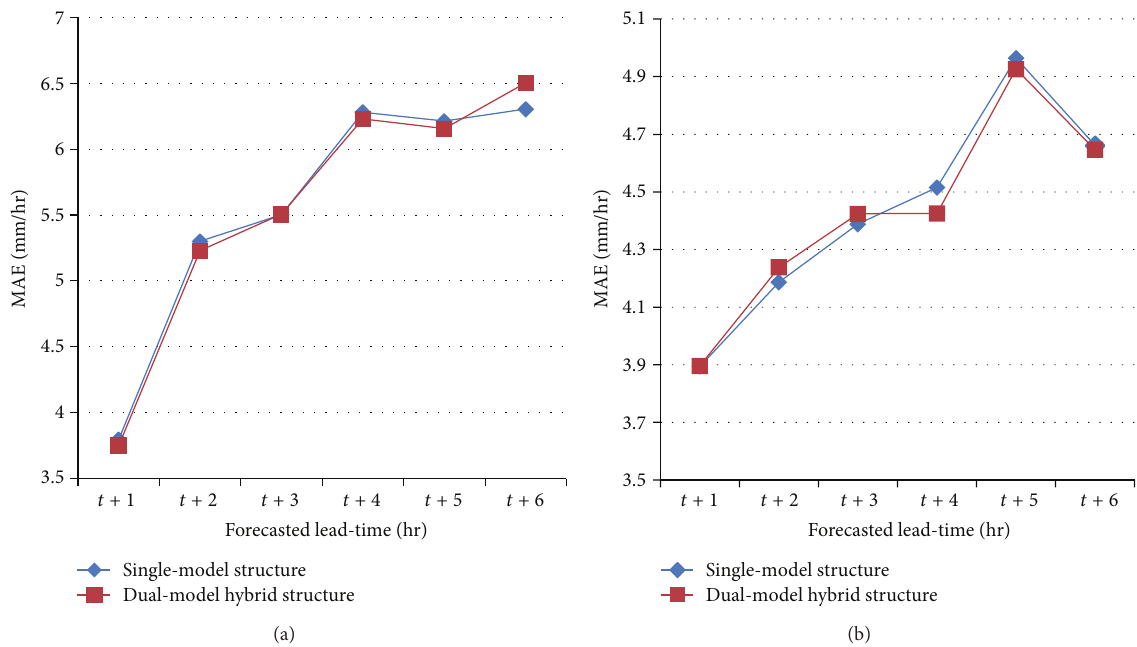
Figure 11: Comparison of the forecast performance of the single and hybrid BPNN-based models at Yu-Feng station: (a) validation; (b) testing.